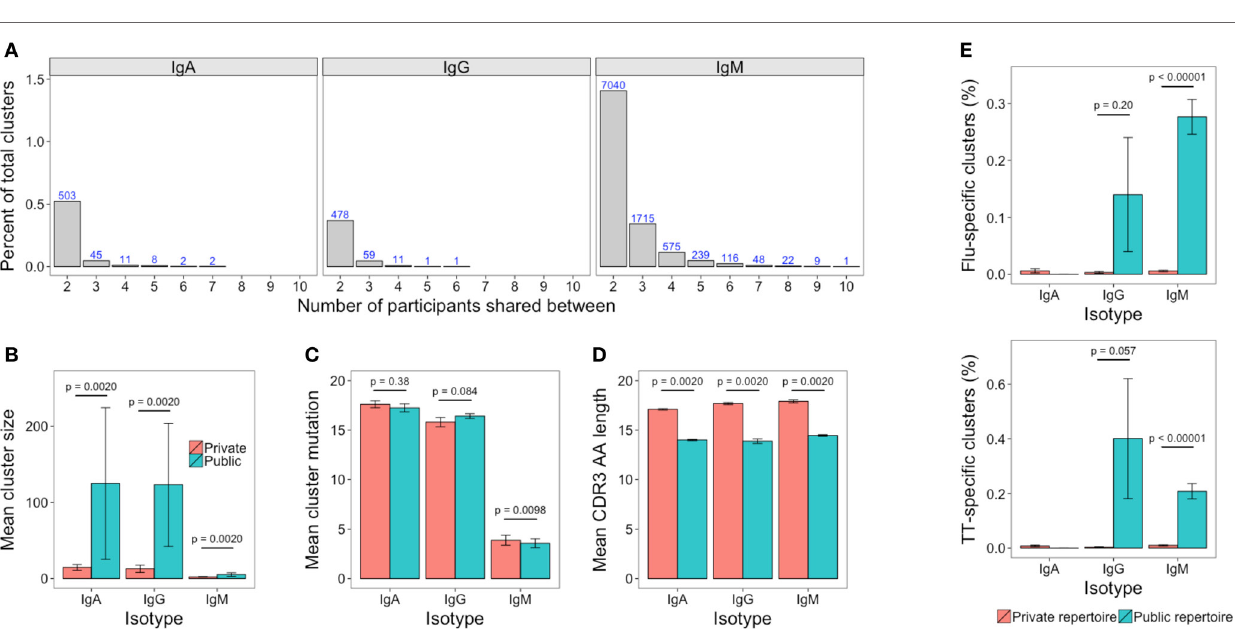
FigUre 7 | The public repertoire . (a) The percent of total clusters that are present in different numbers of participants, where percent = ( A ∩ B /sum( A , B )) × 100. The blue number above each bar shows the absolute number that is shared. (B–D) Mean cluster size, mutation, and CDR3 AA sequence length in the clusters that are unique to a participant (private repertoire) compared to those that are present in at least one other participant (public repertoire). (e) Percent of clusters in the private and public repertoire that are annotated as having specificity toward either TT or Influenza antigens. For (B–e) , mean values ± SEM are shown for the 10 participants. Comparisons performed using the paired Mann-Whitney U